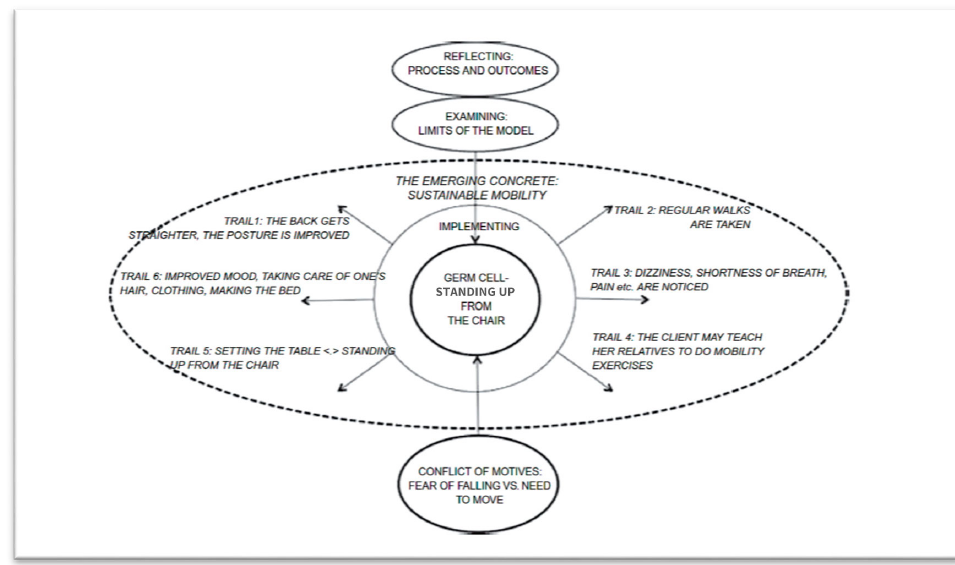
Figure 1. Generative themes in Anne’s situation (Engeström et al., 2012, p.